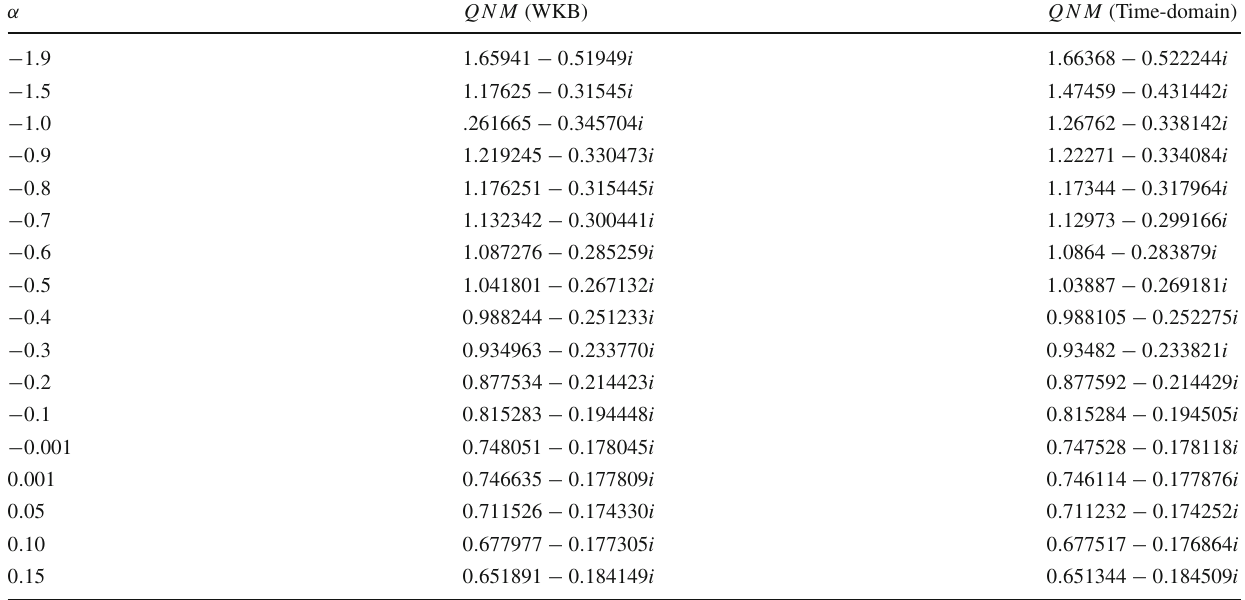
Table 3 Gravitational quasinormal modes of the scalar (polar) type for various values of the coupling constant α in the stability sector; (cid:11) = 2, M = 1 / 2. At α ≈ − 1 . 5 and smaller the two concurrent modes